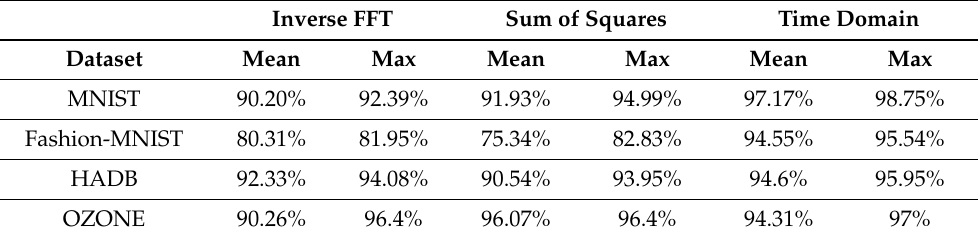
Figure 2. The schema of the proposed CNN architecture. The input is in the frequency domain, the spectral pooling can be done before the element-wise multiplication, and the nonlinear activation function can be applied after each multiplication. Table 1. The table contains the average and maximum of the accuracy achieved on the independent test sets of the examined datasets in case of three different network architectures. One is the reference network in time domain, the other contains the inverse FFT, which was also used in previous articles, and the neural network implemented with the sum of squares solution proposed by us. Inverse